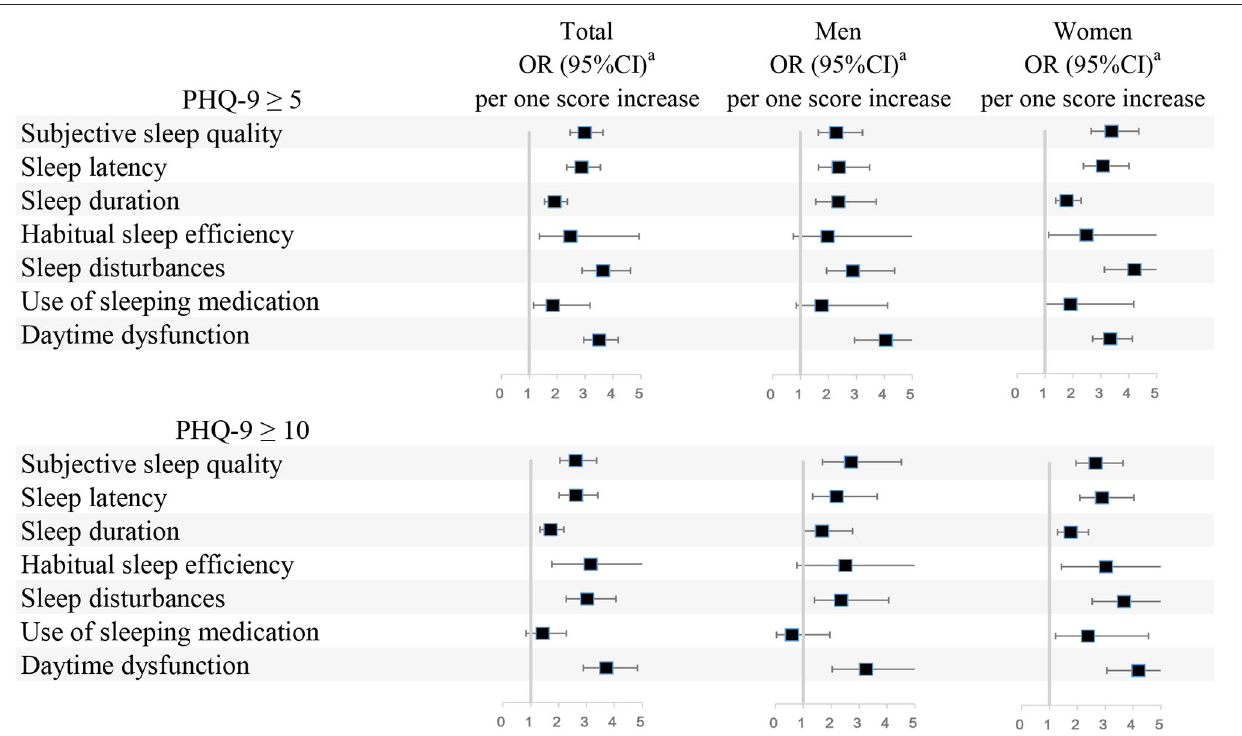
FIGURE 2 | Associations between scores in seven components of the PSQI and depressive symptoms. PSQI, Pittsburgh Sleep Quality Index; PHQ-9, Patient Health Questionnaire-9; OR 95% CI, Odds ratio (95% confidence interval). a Adjusted for age, body mass index, sex (if appropriate), physical activity, household income, working time, night shifts, visiting friends constantly, religious or not, marital status, siblings or not, experienced a major life event or not, current year of residency, smoking status, alcohol consumption, coffee intake, and